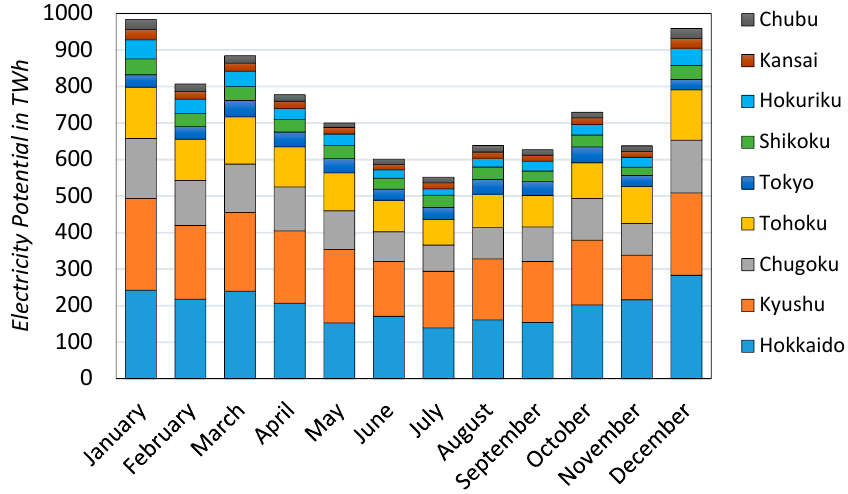
Figure 8. Total electricity potential per month divided by region (2018). 162